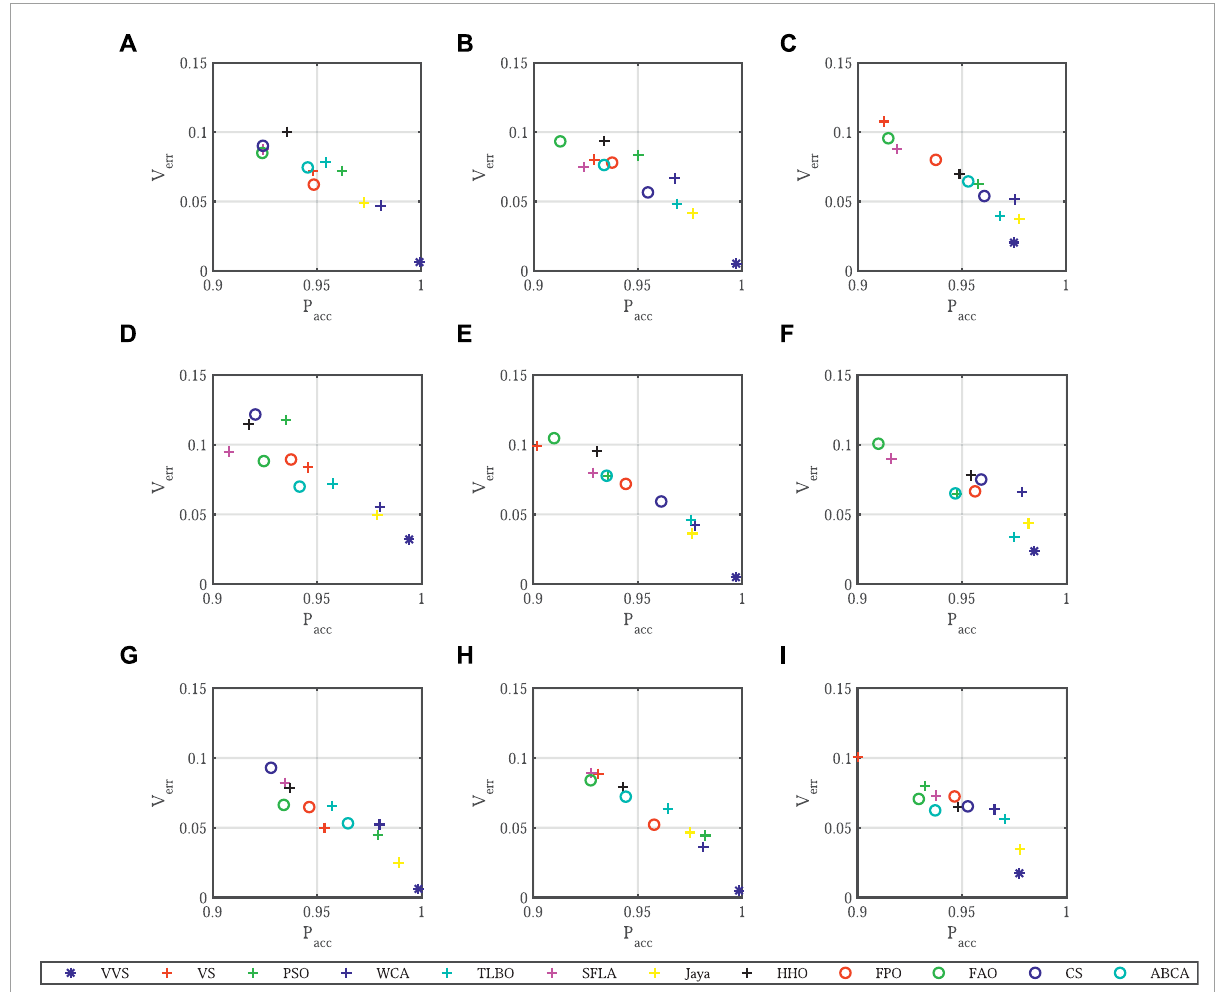
FIGURE 4 V err and P acc test results with different algorithms under (A) PSC1: 3S-KC175GT; (B) PSC2: 5S-KC175GT; (C) PSC3: 7S-KC175GT; (D) PSC4: 3S-N224A01; (E) PSC5: 5S-N224A01; (F) PSC6: 7S-N224A01; (G) PSC7: 3S-JH10; (H) PSC8: 5S-JH10; (I) PSC9: